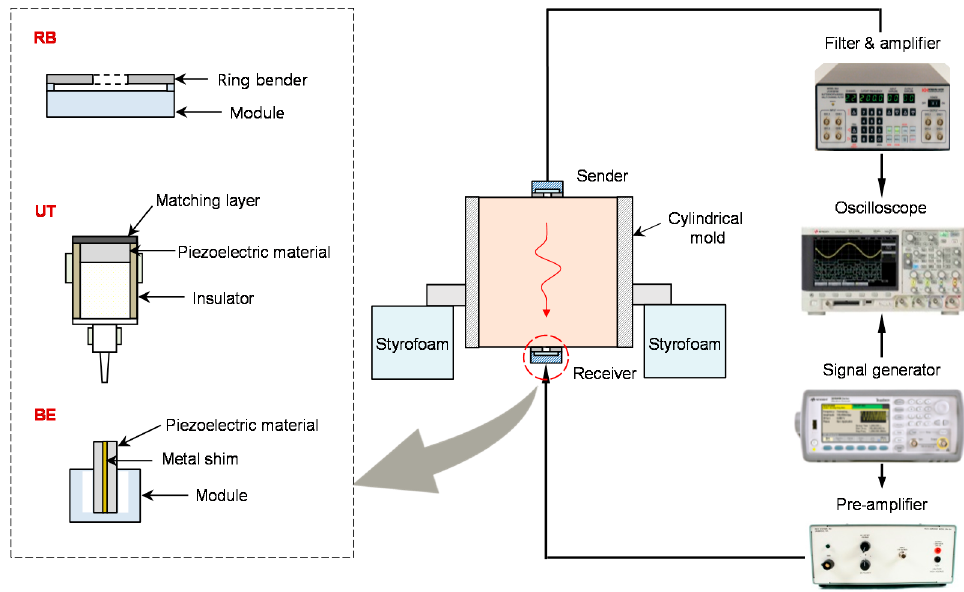
Figure 4. Schematic of the experimental setup for the measurement of shear waves.